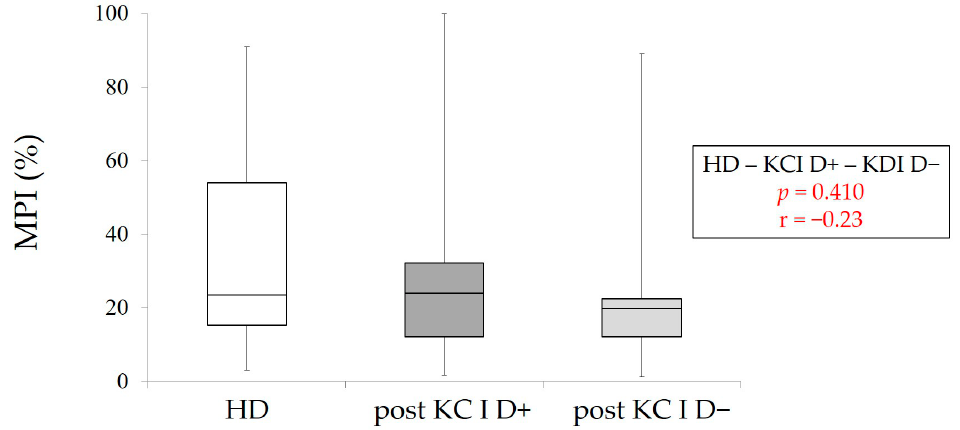
Figure 4. Pre- and post-masticatory function in KC I D+ and D − . The statistical analyses were con- ducted between pre- and post-values in KC I D+ and D − , respectively * p < 0.05, Wilcoxon signed- rank test, r: effect size.